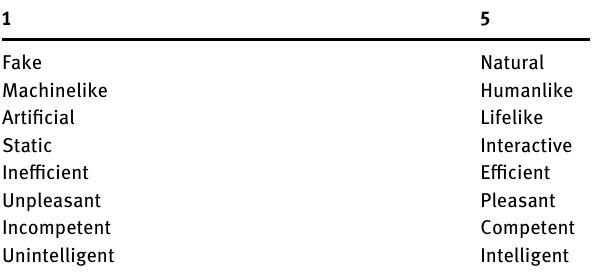
Table 1: The di ff erent attribute pairs used in assessing participants ’ perception of how the robots explained and instructed each other. On a 1 to 5 Likert scale, a ranking of 1 corresponds to “ totally agree ” to the left most attribute of the pair, a ranking of 5 to “ totally agree ” with the right most attribute. The order of presenting these pairs was shu ffl ed for each video and each participant, and they ap - peared in random